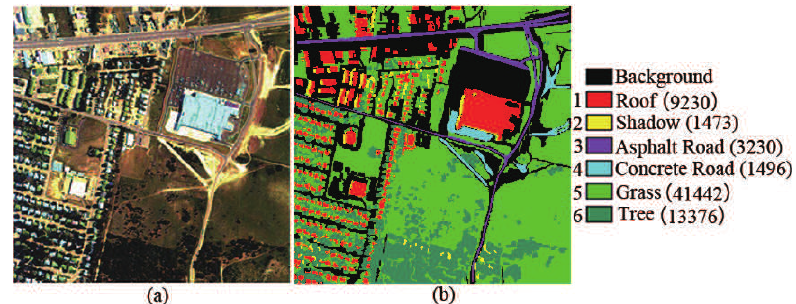
Figure 6. Urban hyperspectral image. ( a ) HSI in false color; ( b ) Ground